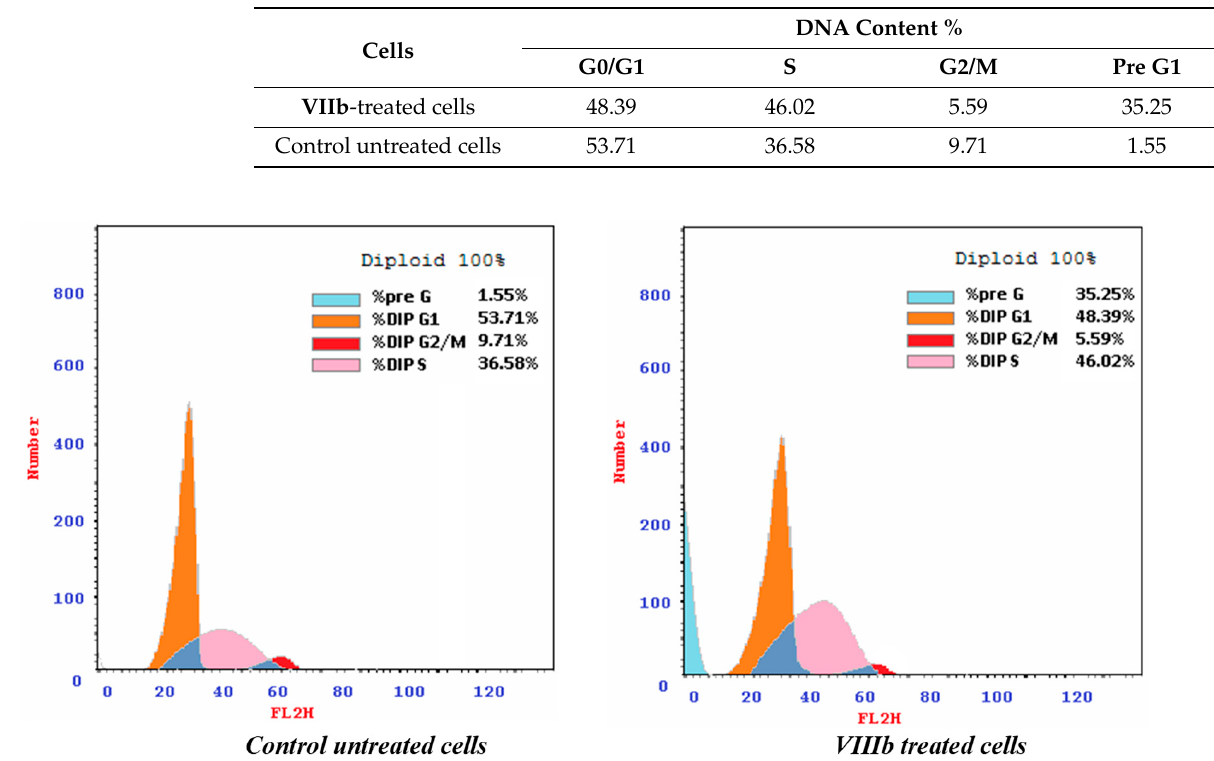
Figure 4. The cell distribution in cell cycle phases following Compound VIIb